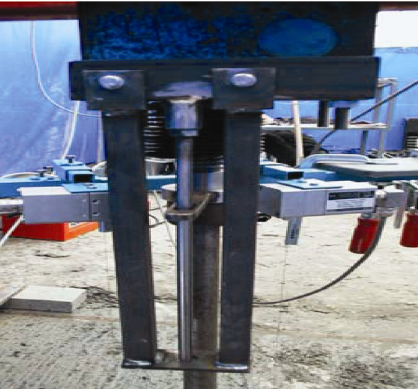
Fig. 7. Bucket load test device used for performing vertical load tests